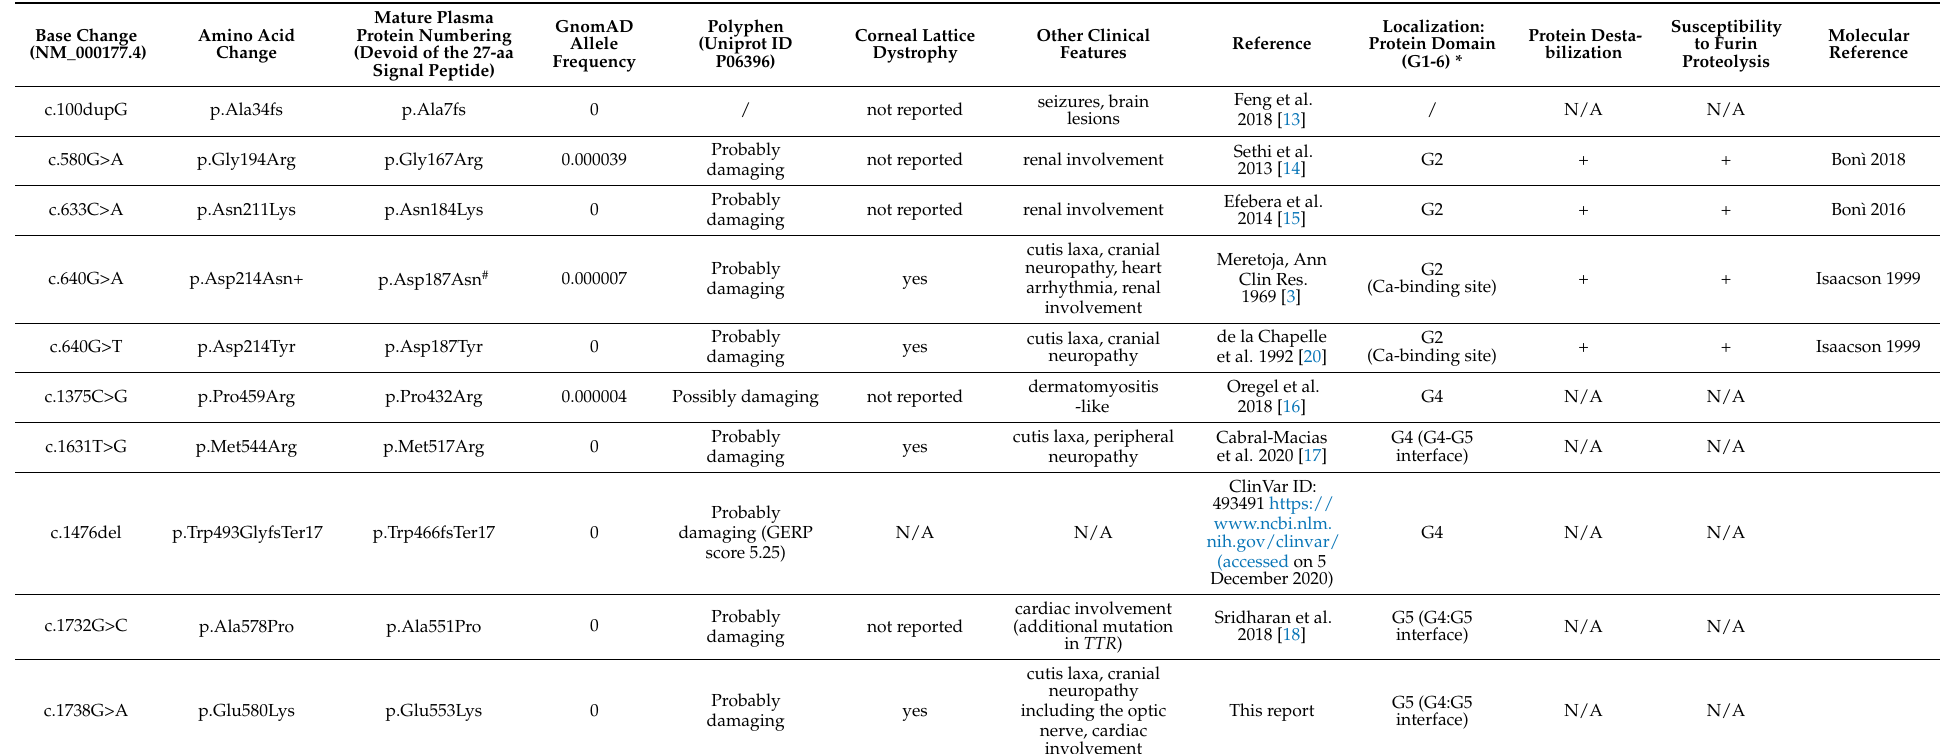
Table 2. GSN mutations and associated